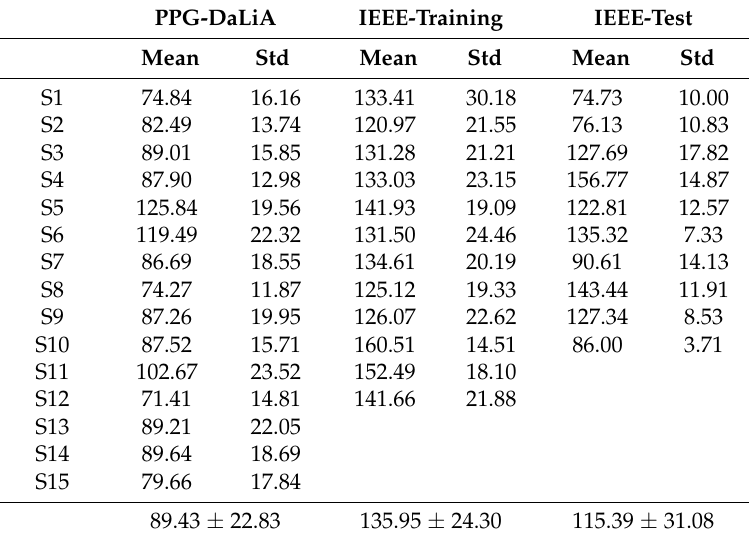
Table 3. Comparison of the datasets PPG-DaLiA , IEEE_Training , and IEEE_Test : Session-wise details